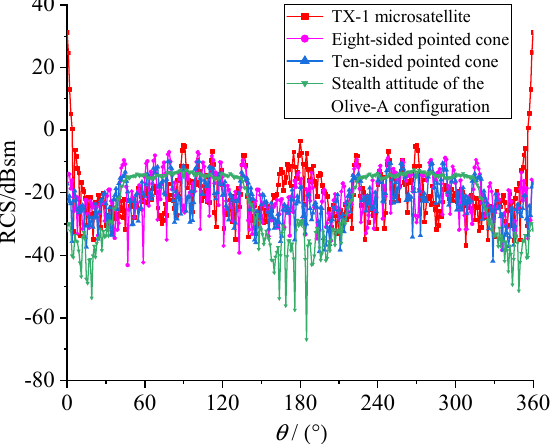
Figure 5. RCS distribution at 10 GHz for 4 satellite configurations.